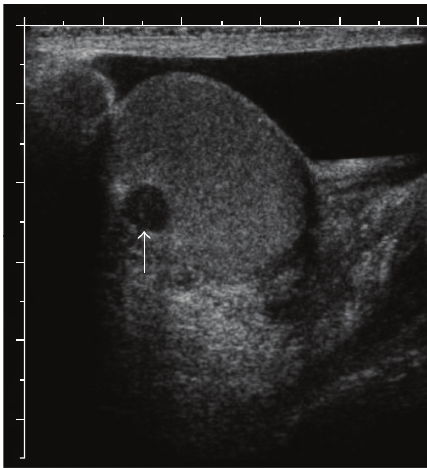
Figure 1: Ultrasound of the right testis, longitudinal view. A hypoechoic lesion (arrow) is seen in the posterior testis, near the mediastinum testis.